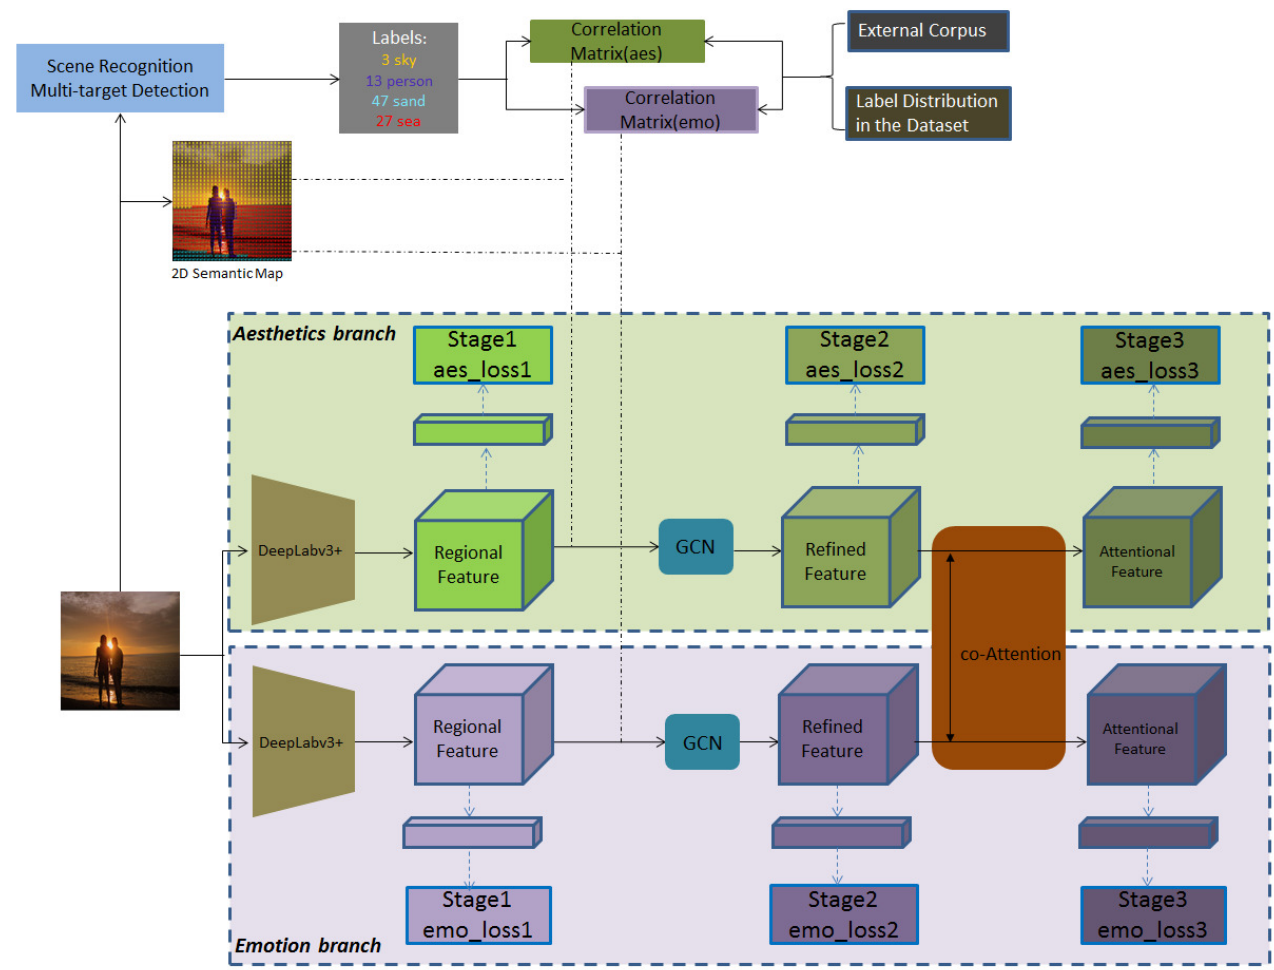
Figure 1. Illustration of our proposed